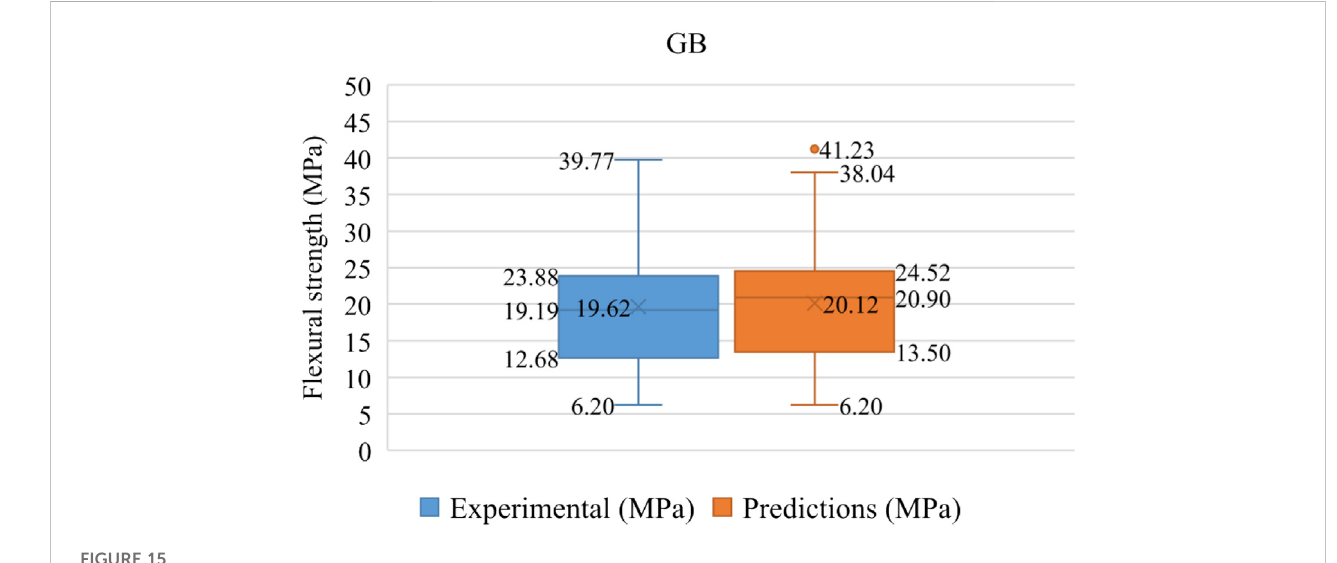
FIGURE 15 Box plot for actual and predicted results — GB model.